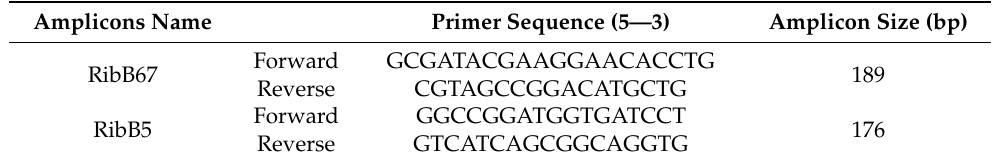
Table 1. Primer sequences for